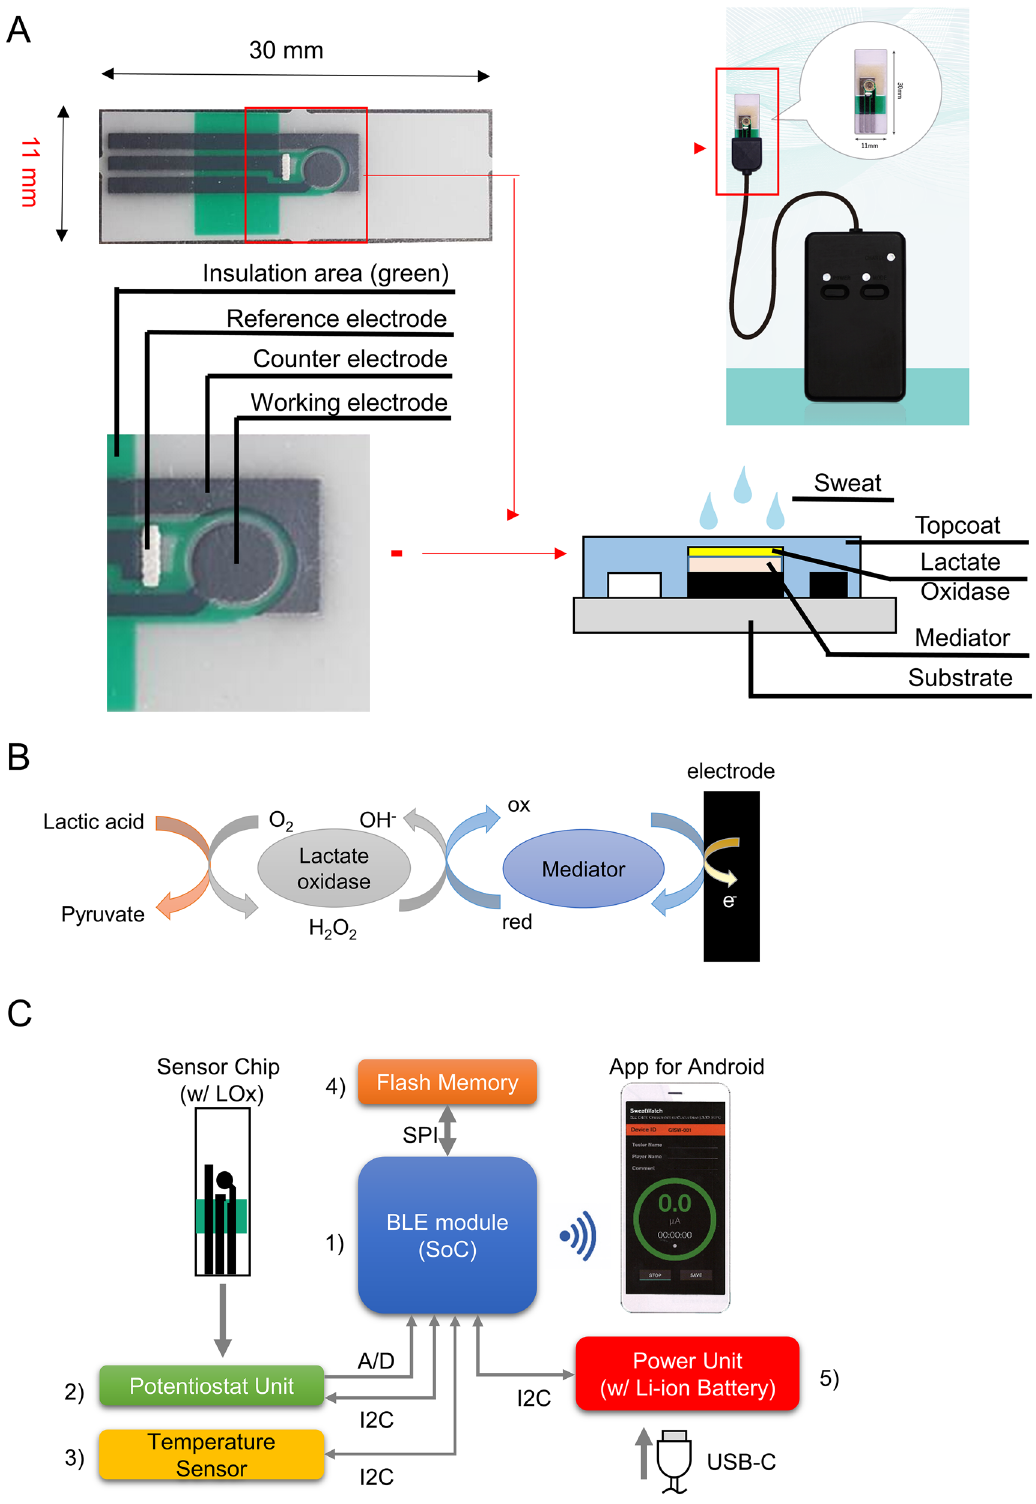
Figure 5. Fabrication and function of the sweat lactate sensor chip. ( A ) Parts composition of the lactate acid sensor chip. ( B ) Schematic diagram of the reagent layer and processes involved in the amperometric sensing of lactate acid on the working electrode. ( C ) The parts composition of device. (1) Bluetooth LE System-on-Chip: Taiyo Yuden EYSHCNZWZ, (2) Potentiostat unit: Texas Instruments DAC081C085 (DAC), Microchip Technology MCP6041T-I/OT and MCP6042T-I/MS (OP AMP), (3) temperature sensor: Ablic S-5851A, (4) flash memory: Winbond Electronics W25Q32JV(4 MB), (5) power unit: Texas Instruments BQ24232RGTR (Charger IC), Synergy ScienTech AHB512229PR (Li-ion Battery: 3.7 V, 295 mAh) and ON Semiconductor LC709203F (fuel